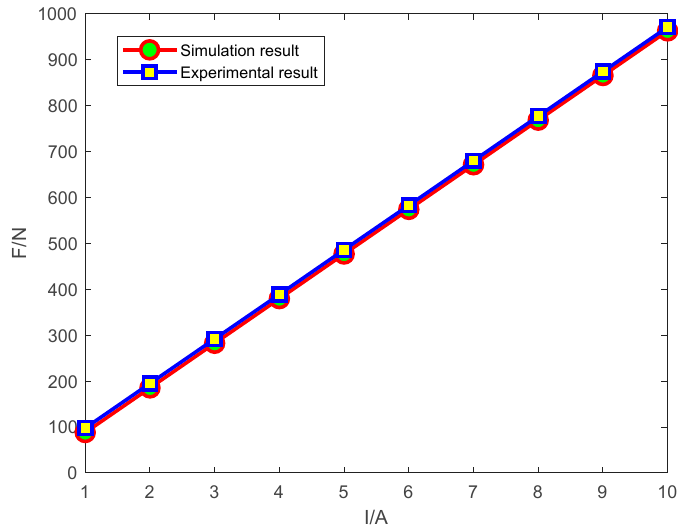
Figure 14. Simulation and experimental output thrust curves.